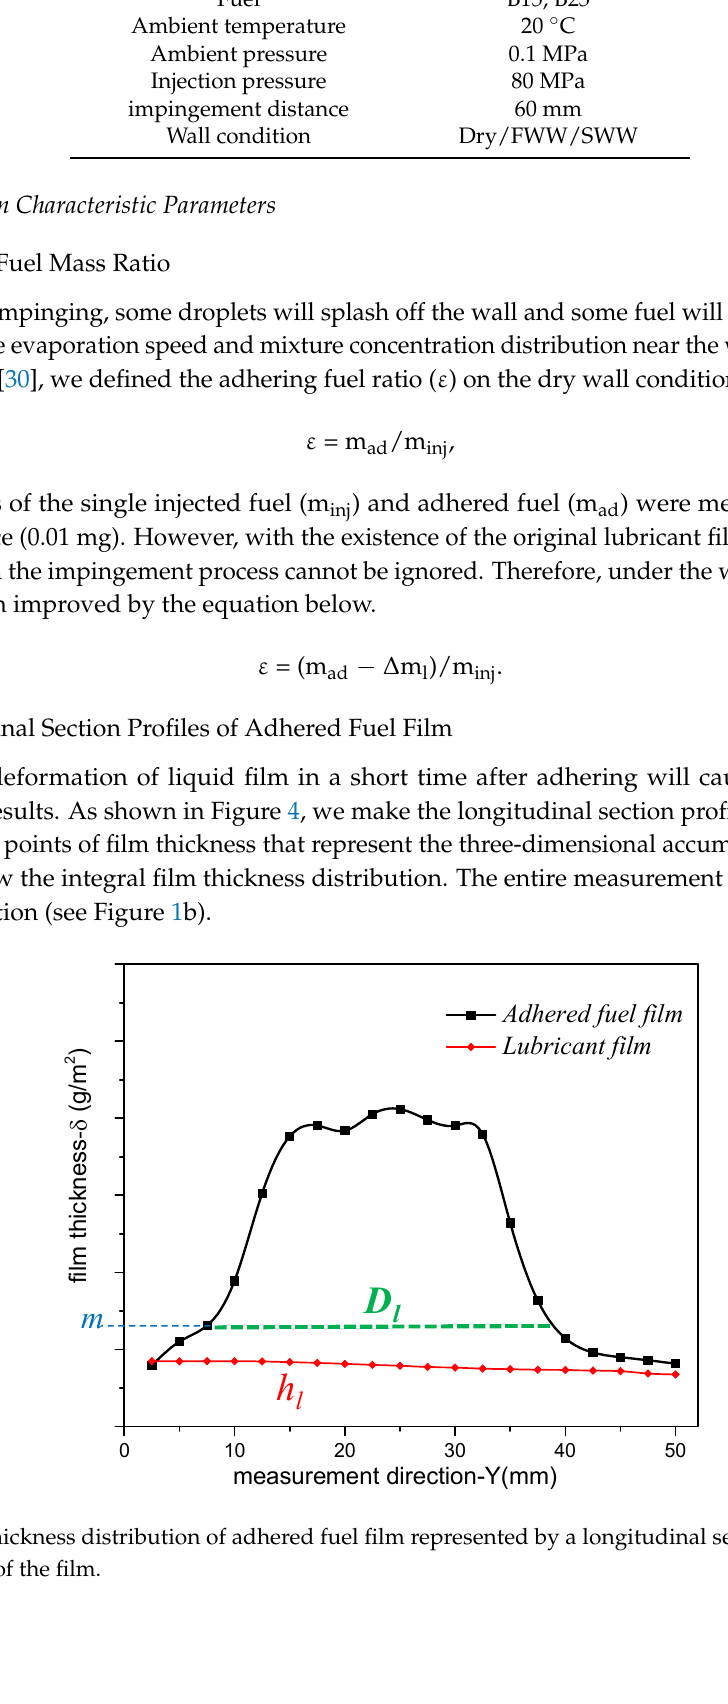
Table 3. Experimental conditions.